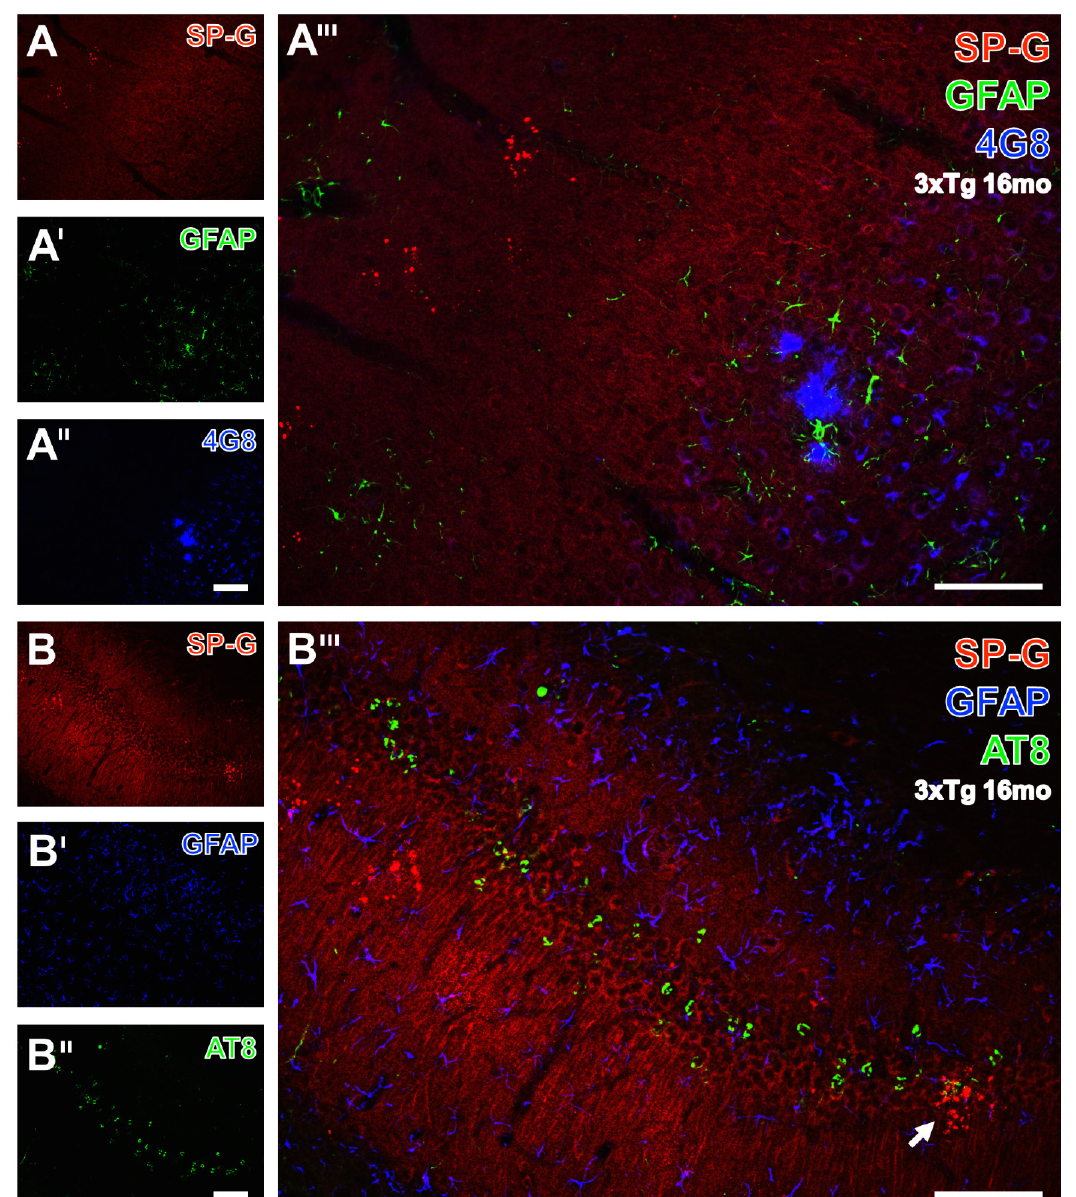
Figure 8. Triple fluorescence labeling of SP-G, astroglia, and β -amyloid deposits (A β ) or hyperphos- phorylated protein tau (phospho-tau) in the hippocampus of a 16 month-old 3xTg-AD mouse. In ( A ), two clusters of SP-G-containing red fluorescent dots in the stratum oriens of the CA3 region become visible. Concomitantly, the GFAP staining ( A’ ) is not evenly distributed and appears strongest in the pyramidal layer of the CA3 region. The same region displays three 4G8-positive, A β -containing plaques ( A” ) located in close vicinity. These blue deposits are surrounded by activated astrocytes, whereas plaques and astroglia are seen only distant from SP-G dots. ( B – B”’ ) demonstrate the simulta- neous staining of SP-G, phospho-tau, and GFAP, exemplifying the control experiment with switched fluorophores, e.g., green-fluorescent Cy2 for the AD-like lesions and Cy5 (color-coded in blue) for astroglia. Dot-like SP-G-ir ( B ) appears mostly clustered in the polymorph layer of the dentate gyrus and in the granular cell layer, which contains numerous neurons filled with hyperphosphorylated tau ( B” ) but displays (in B’ ) weaker GFAP-ir than, for instance, the stratum lacunosum-moleculare of the CA1 field. Merging of staining patterns ( B”’ ) does not reveal co-localization of the visualized markers, except for one cluster of SP-G-dots in the neighborhood of neuronal phospho-tau in the granular layer (arrow). Scale bars: B” (also valid for A – A” , B , B’ ) = 100 µ m, B”’ (also valid for A”’ ) = 100 µ